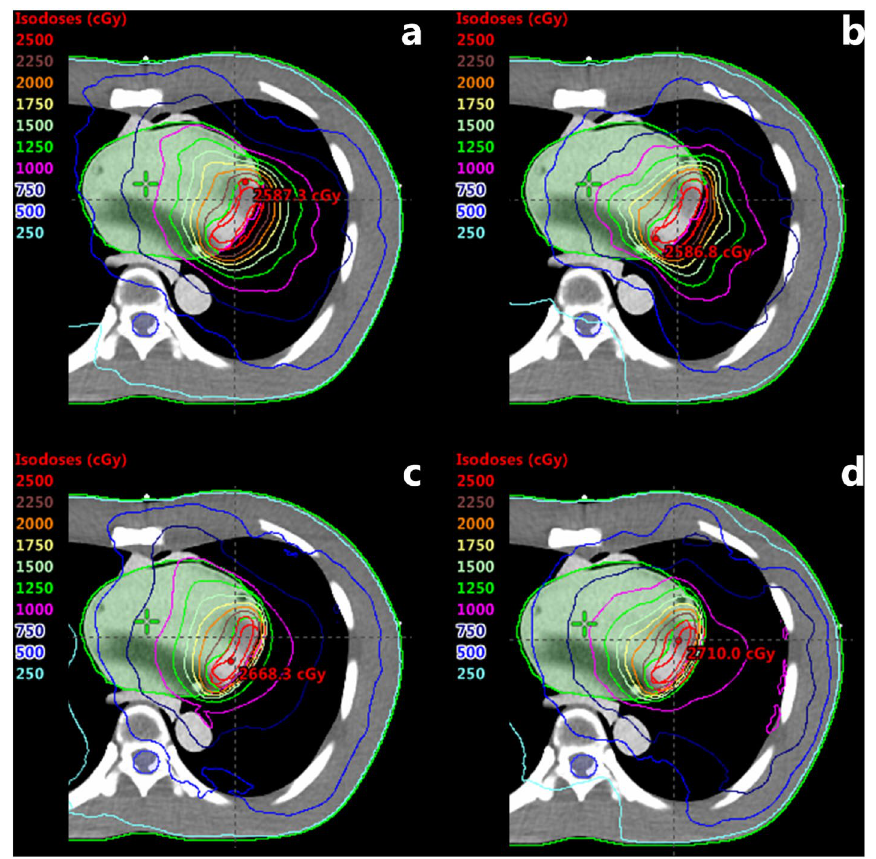
Figure 5. Volumetric modulated arc therapy (VMAT) plans using 15-MV photon beams. ( a ) Full arc treatment (AAA Algorithm), ( b ) half arc treatment (AAA Algorithm), ( c ) full arc treatment (AXB Algorithm), and ( d ) half arc treatment (AXB Algorithm).